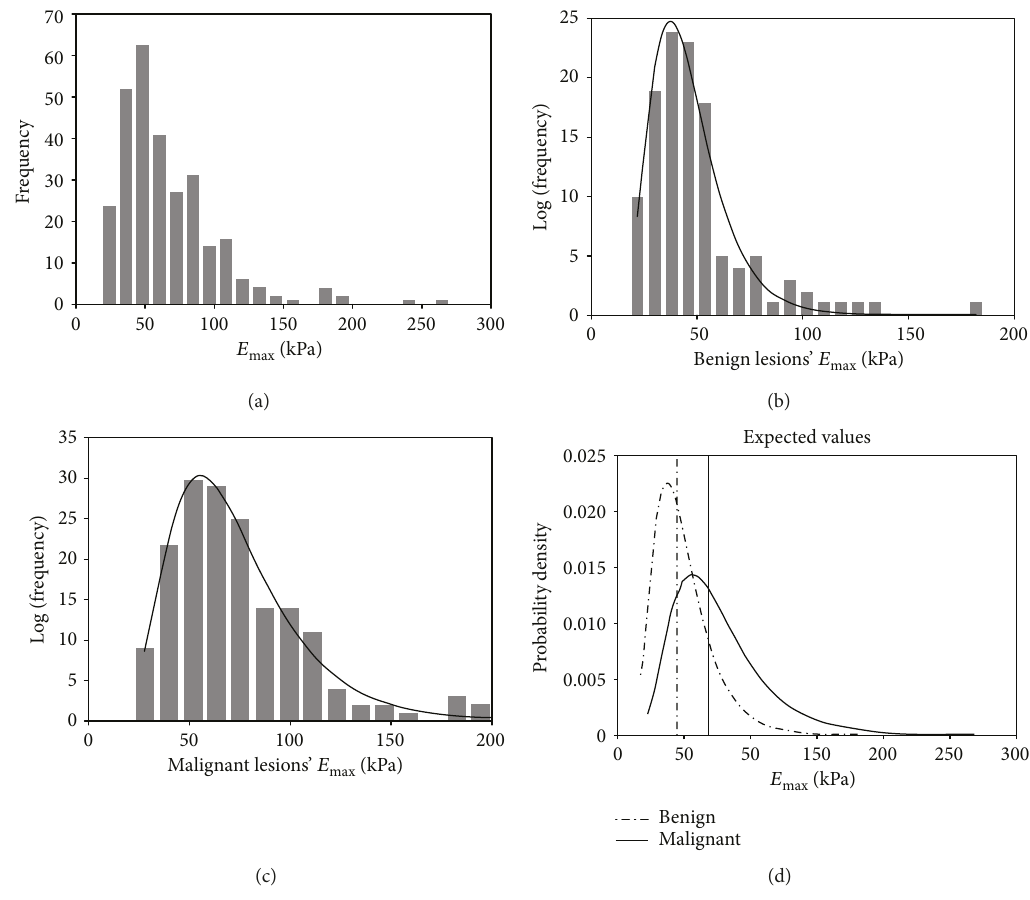
E max . (b) Log-normal frequency distribution